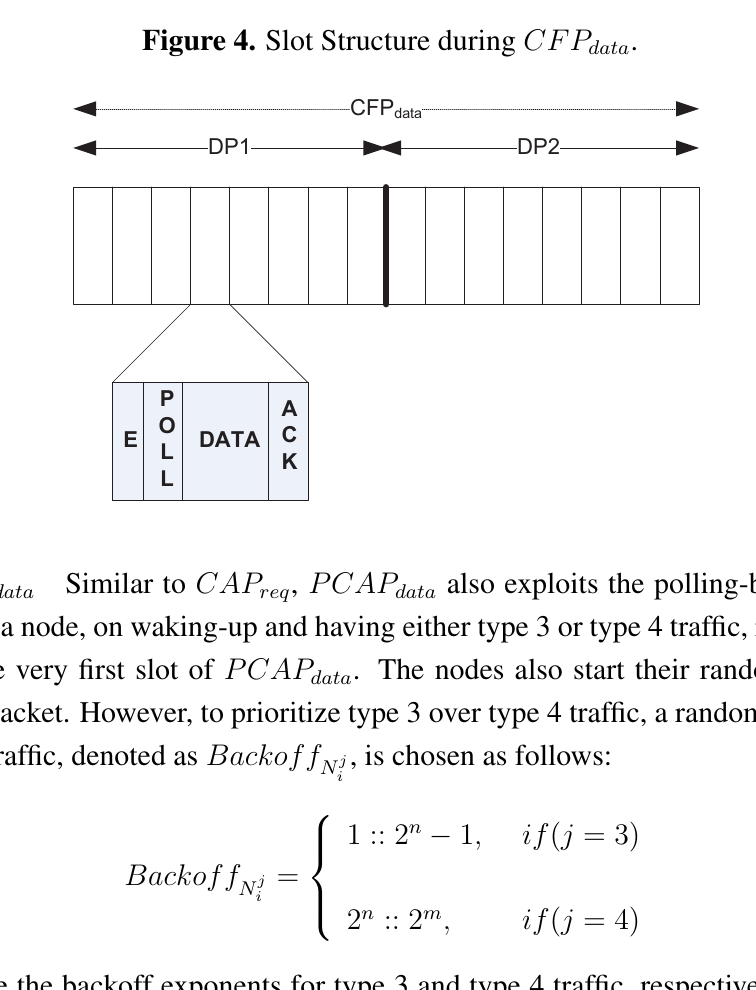
Figure 4. Slot Structure during CF P